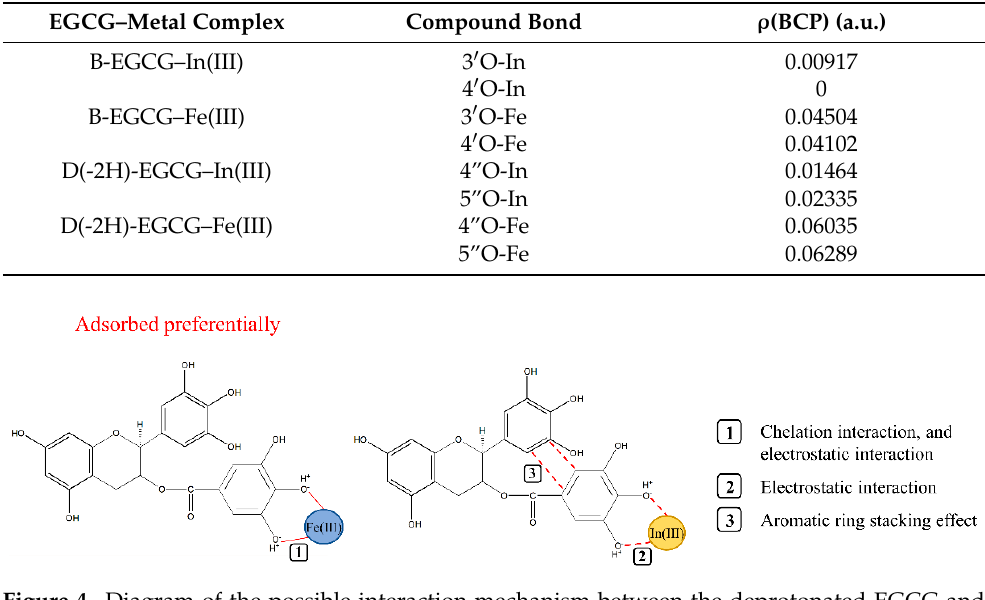
Table 2. Electron density at different BCP positions in the complexes.